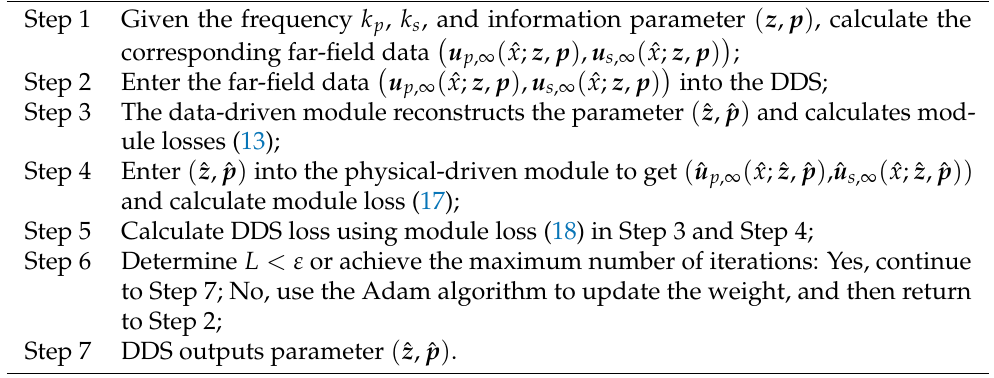
Algorithm 1 A numerical method for reconstructing the source from far-field